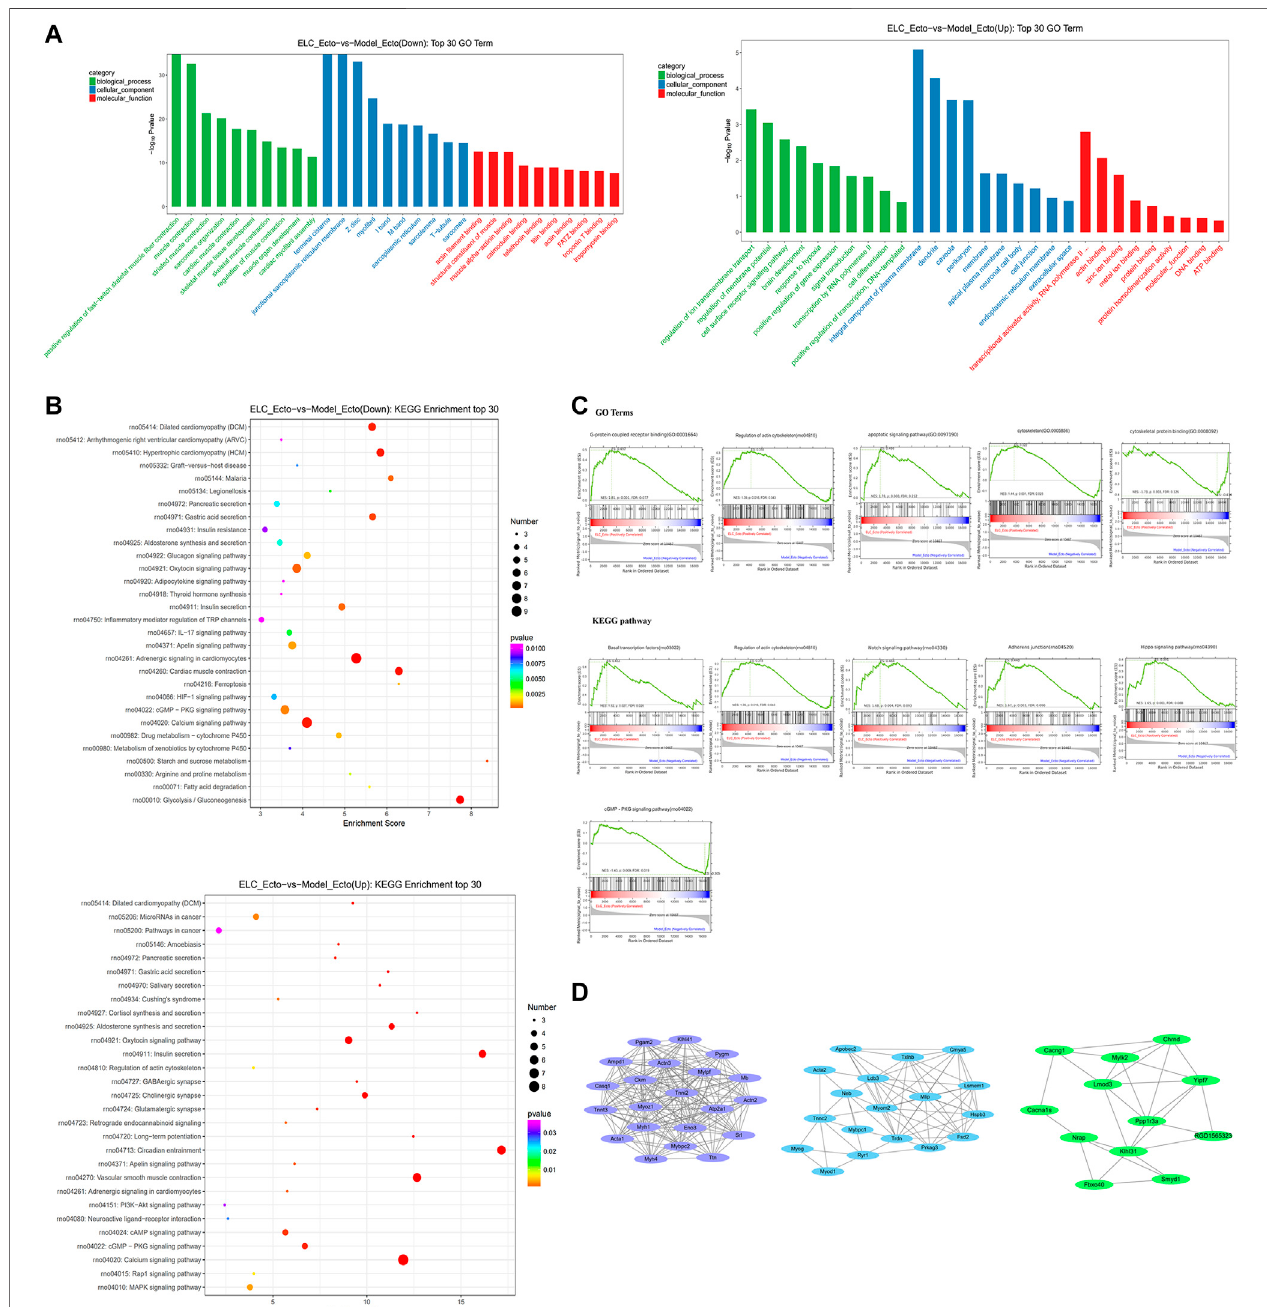
FIGURE 7 | RNA-sequencing reveals the transcriptome pro fi le of gene expression changes in the treatment with ELC. The related genes and pathways regulated by ELC were found through comparing the DEGs between the Model_Ecto group and the ELC_Ecto group. (A) Results of gene ontology enrichment analysis for upregulated DEGs and downregulated DEGs reversed by ELC ectopic endometrium groups and model ectopic endometrium groups. (B) Results of KEGG enrichment analysis between ELC_Ecto groups and Model_Ecto groups. (C) The results of GSEA revealed a signi fi cant enrichment of gene signatures associated with ELC treatment ( p < 0.05). (D) MCODE network of cluster analysis of the potential targets network in ELC treatment.